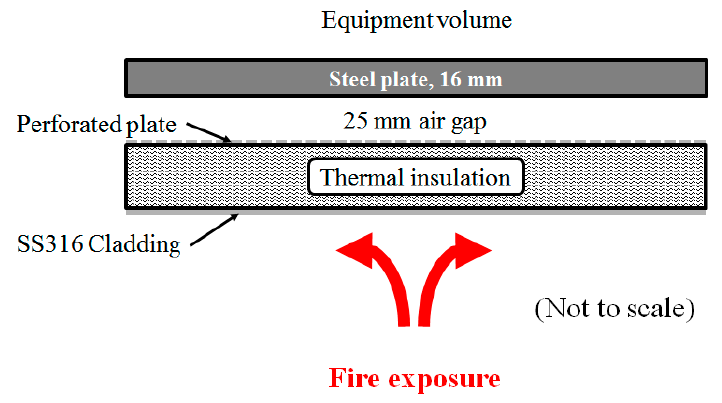
Figure 2. Conceptual sketch 1 of the fire test set-up.